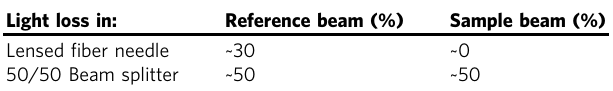
arm): lensed fi ber needle vs. conventional 50/50 beam